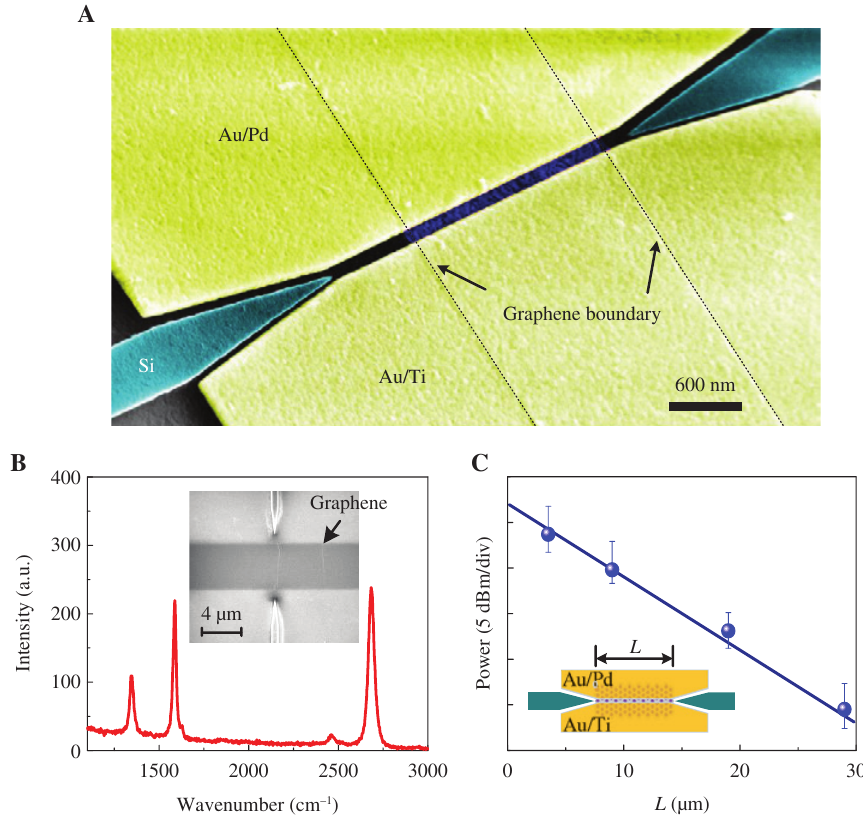
Figure 2: Characterization of the fabricated device. (A) Example of fabricated graphene plasmonic photodetector with the graphene coverage length of 2.7 μ m. (B) Measured Raman spectrum for the graphene after the wet-transfer process. The inset shows the scanning electron microscope (SEM) image of the device with 2.7 μ m after the graphene patterning process. (C) Analysis of coupling and propagation loss by the cut-back method. The error bar is obtained by measuring six copy devices with the same graphene coverage